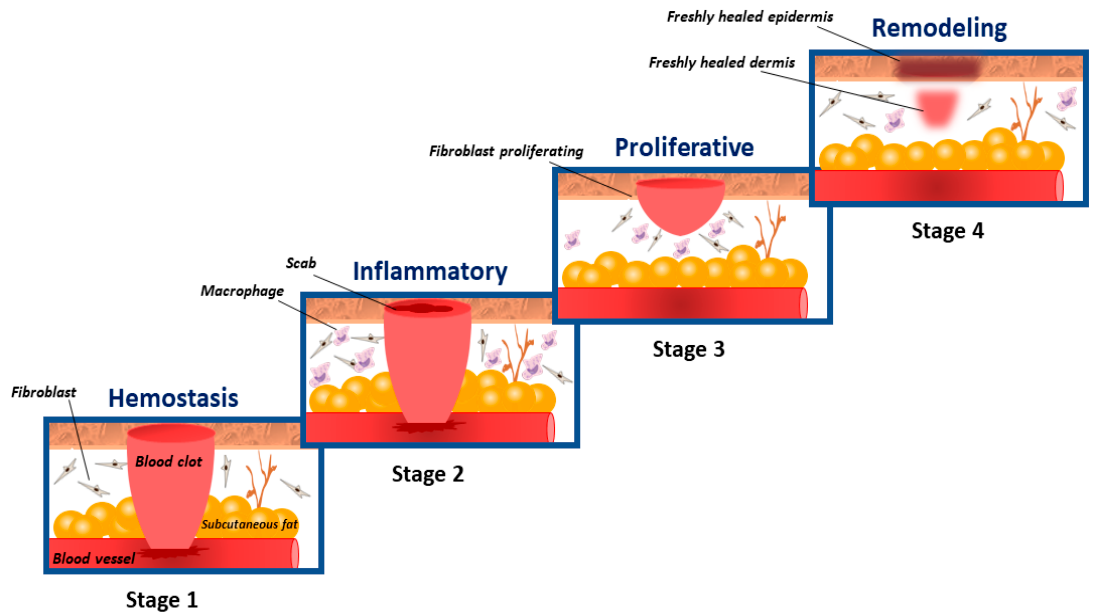
Figure 1. Different stages of the wound-healing process.